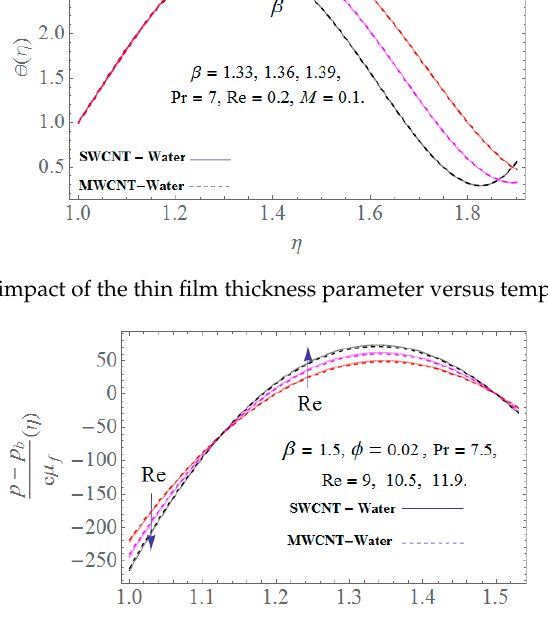
Figure 10. Impact of the Reynold number versus pressure distribution. Processes 2019 , 7 , x FOR PEER REVIEW